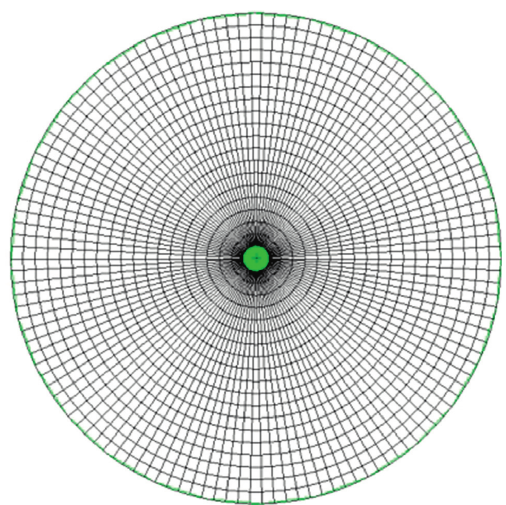
Figure 1: Finite element mesh of the disk. Table 1: Material properties of the disk.